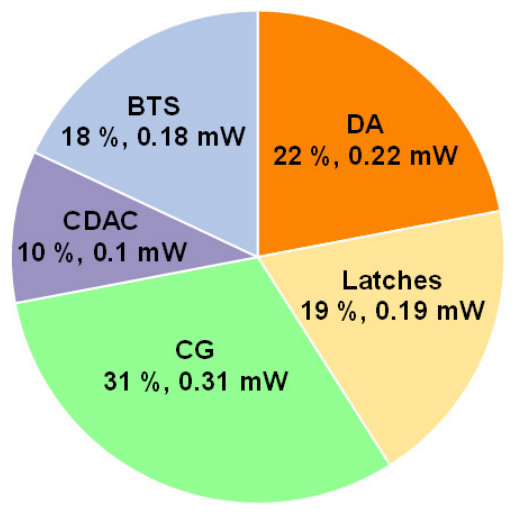
Figure 15. Measured SNDR and SFDR with various supply voltages within ± 10%.